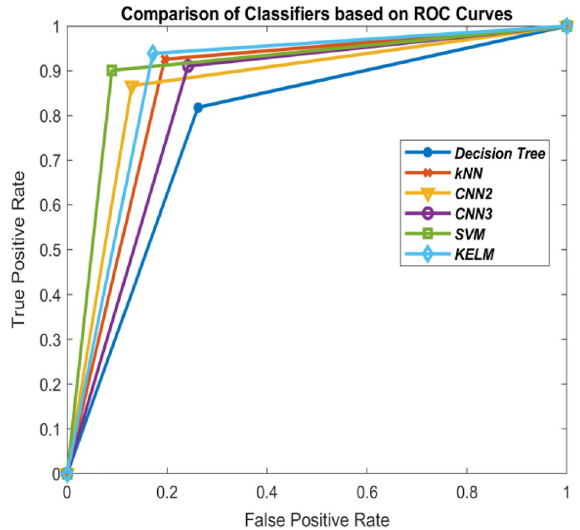
Figure 10. Comparison of the classifiers based on ROC curves (10–90 train-test ratio) of CoViD19+ve and